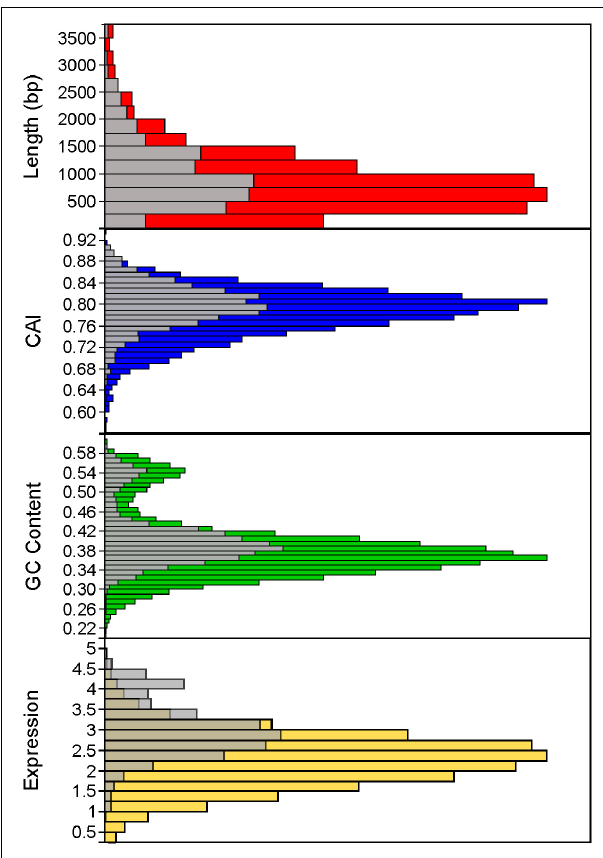
FIGURE 5 | Distribution of core genome compared to non-core genome. The distribution of the core genome (gray bars) to non-core genome (colored bars) is shown for several characteristics, including gene length (in base pairs), codon adaptation index, GC content, and expression (measured by log 10 RPKM). Histograms combine all organisms.